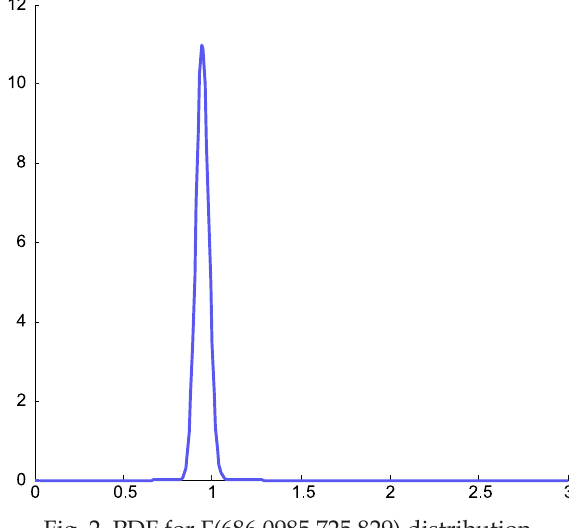
Fig. 2. PDF for Γ(686.0985,725.829) distribution.